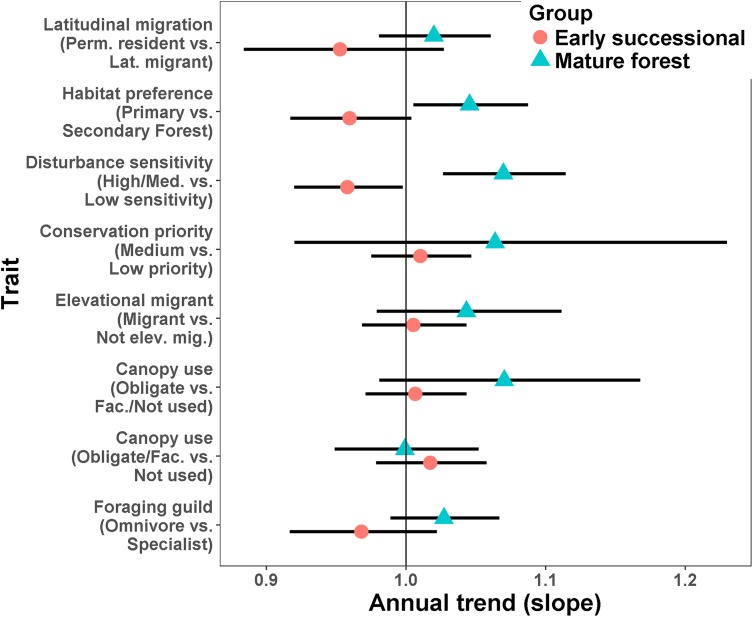
Mean trends in abundance for birds in secondary forest fragments in Costa Rica.Points are transformed slopes from Poisson-normal mixed effects models with species as a random effect, and represent mean changes in abundance for species with different habitat preferences or traits. Error bars are approximately 95% CI.